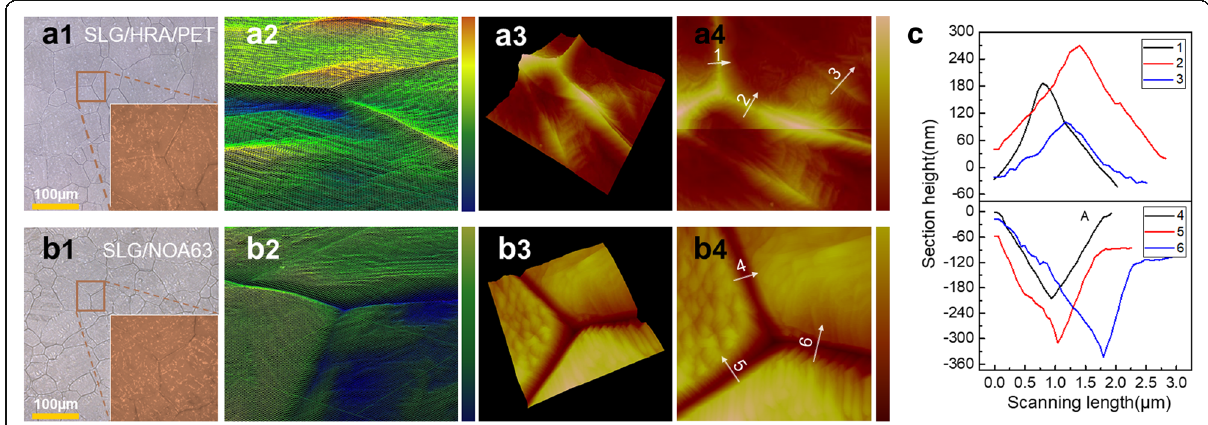
Fig. 3 a1 Two-dimensional plan maps of graphene on HRA/PET. a2 Locally enlarged three-dimensional view of a1 . a3, a4 Three-dimensional AFM image and the corresponding two-dimensional map of graphene on HRA/PET. b1 Two-dimensional plan maps of graphene on NOA63. b2 Locally enlarged three-dimensional view of b1 . b3 , b4 Three-dimensional AFM image and the corresponding two-dimensional map of graphene on NOA63. c Section height of AFM of point 1 –